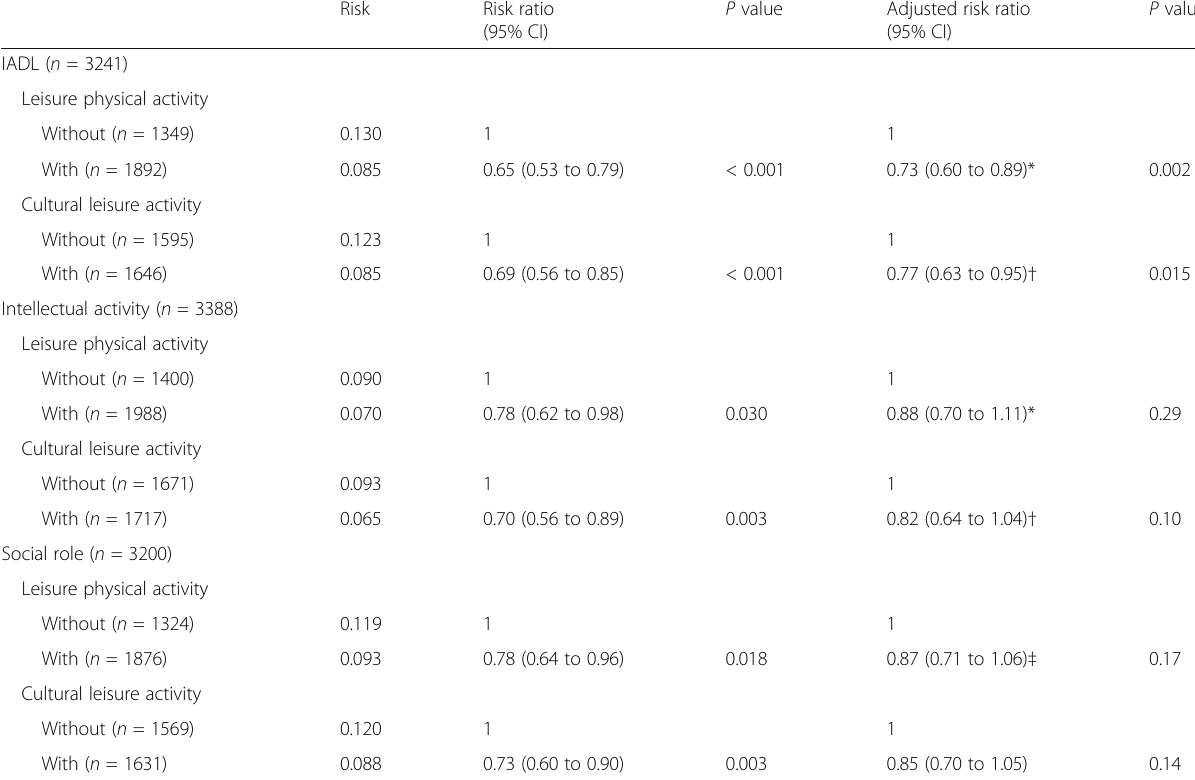
Table 2 Risk for functional decline in 5 years by engagement in leisure